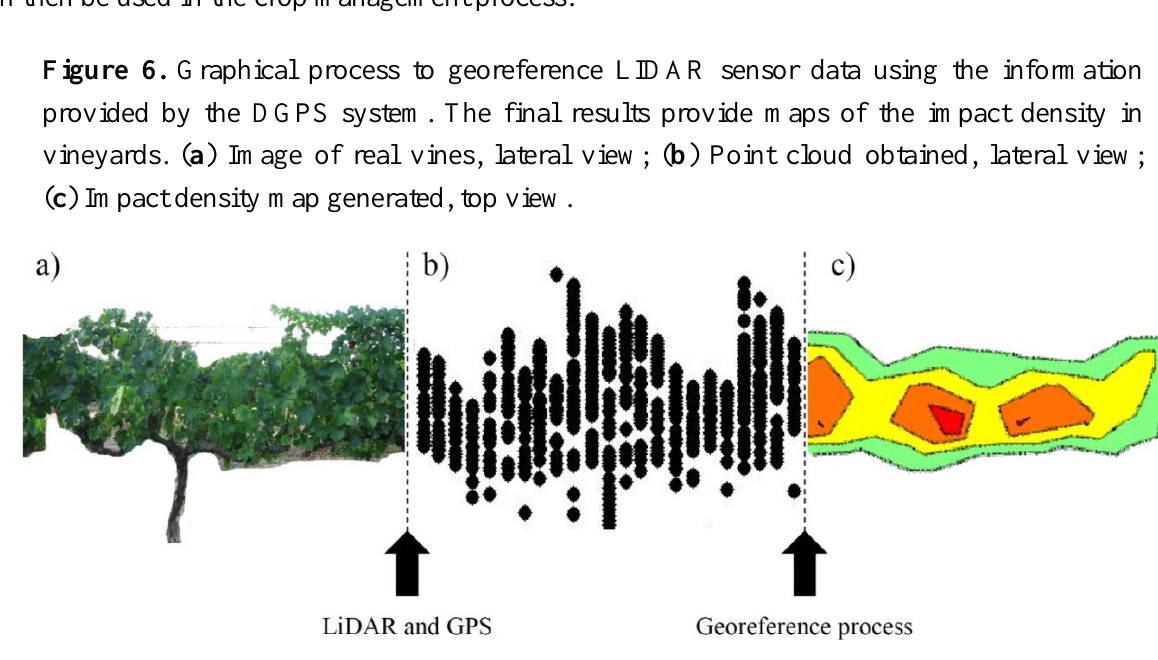
Figure 7. Procedure for conversion of an image file to a KMZ file. This proposed method superimposes the density map on the image of the field (published in [8] with permission of the editor of Sensors